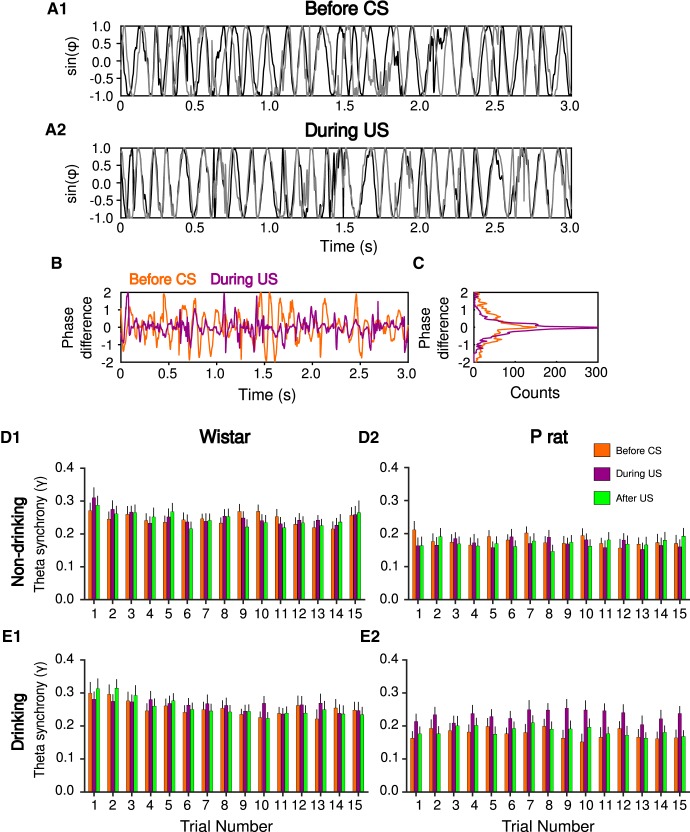
Physiologic differences are observed in the phase domain. Phase synchrony between the mPFC (black) and NA (gray) before drinking (A1) and during drinking (A2) indicate oscillations are more in phase during drinking, relative to before drinking. The difference in phase during (purple) and before (orange) drinking (B). Histogram of phase difference during drinking trials, notice more pronounced peak at zero indicating more synchronized phases (C). Theta band synchrony index (γ) for Wistar (D1, E1) and P rats (D2, E2) before the CS (orange), during the US (purple), and after the US (green) over 15 non-drinking (D) and drinking trials (E). Values are mean ± SEM.